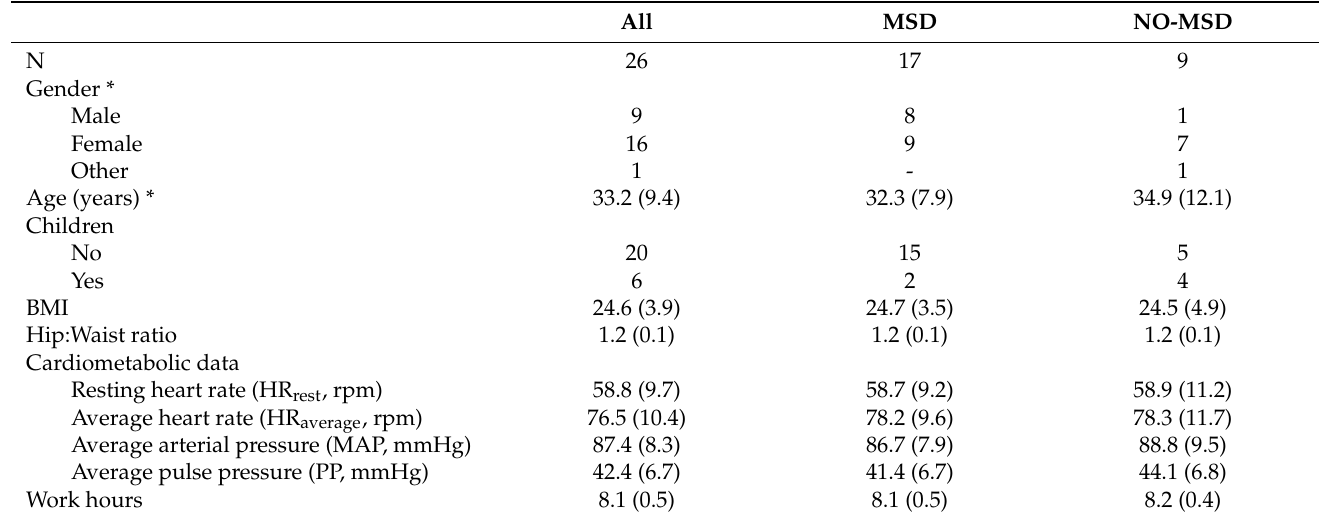
Table 1. Demographics and cardiometabolic data of